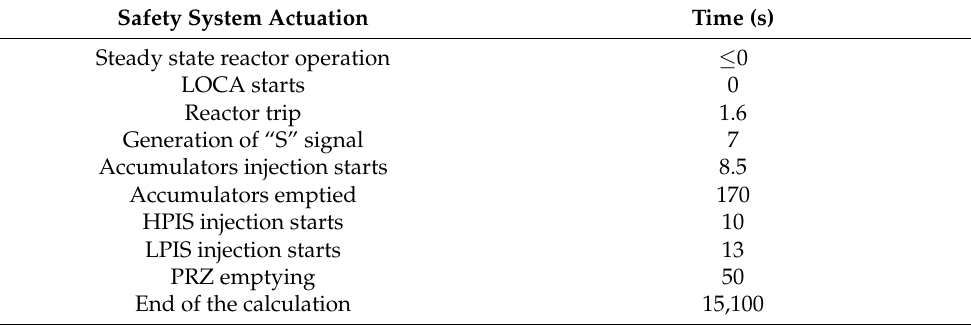
Figure 5. Flow rate of coolant at the core inlet. At the time of cold leg rupture, the outlet primary pressure increased, then it sharply dropped in less than 10 s, as shown in Figure 6. The broken cod leg depressurized faster than unbroken legs of RPV. The reactor primary pressure performance was similar in both analyses of RPV and PRZ.